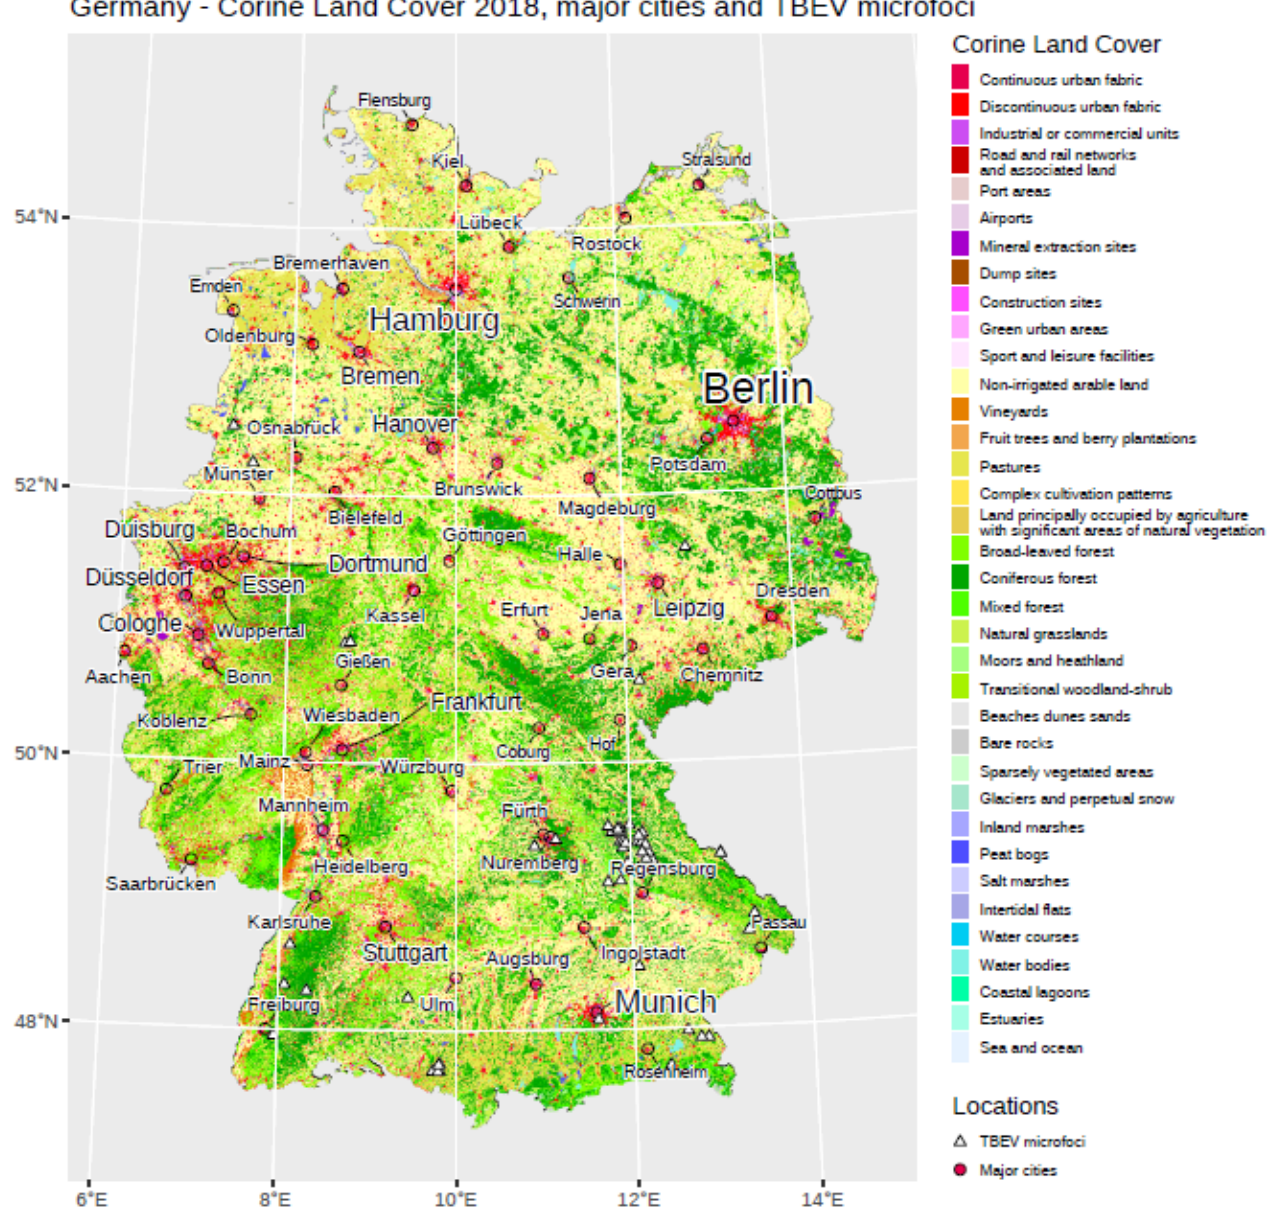
Figure 1. General overview regarding different land cover classes in Germany. Major cities are displayed, as well as the location of TBEV microfoci used in our